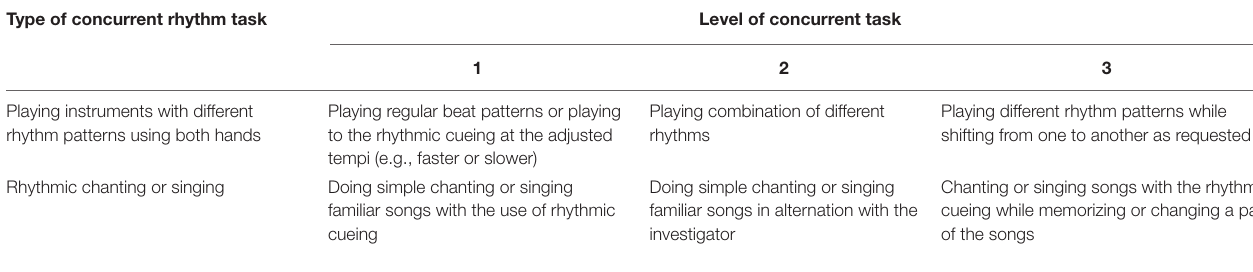
TABLE 2 | Contents of concurrent dual task used during